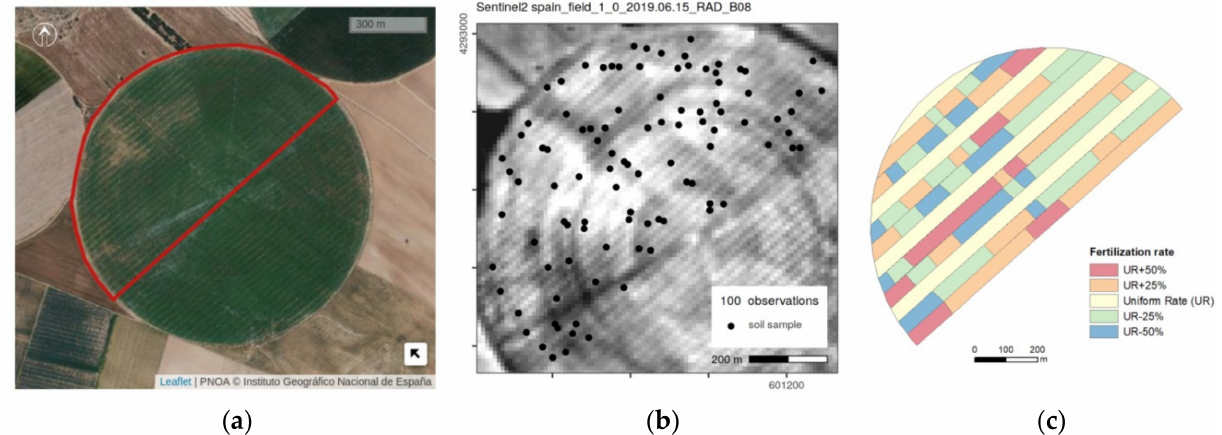
Figure 1. Study area in Albacete, southeastern Spain ( a ), validation soil sampling distribution ( b ) and variable-rate treatment fertilization zones ( c